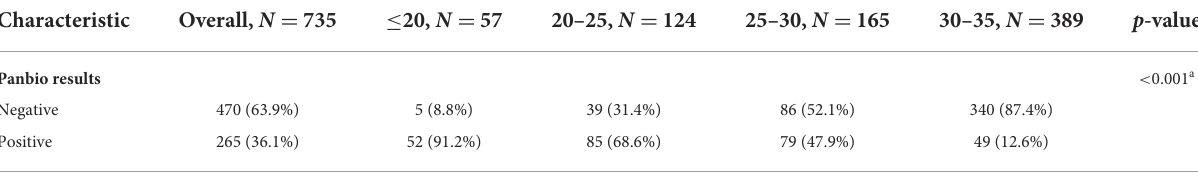
TABLE 5 Panbio sensitivity among cycle threshold